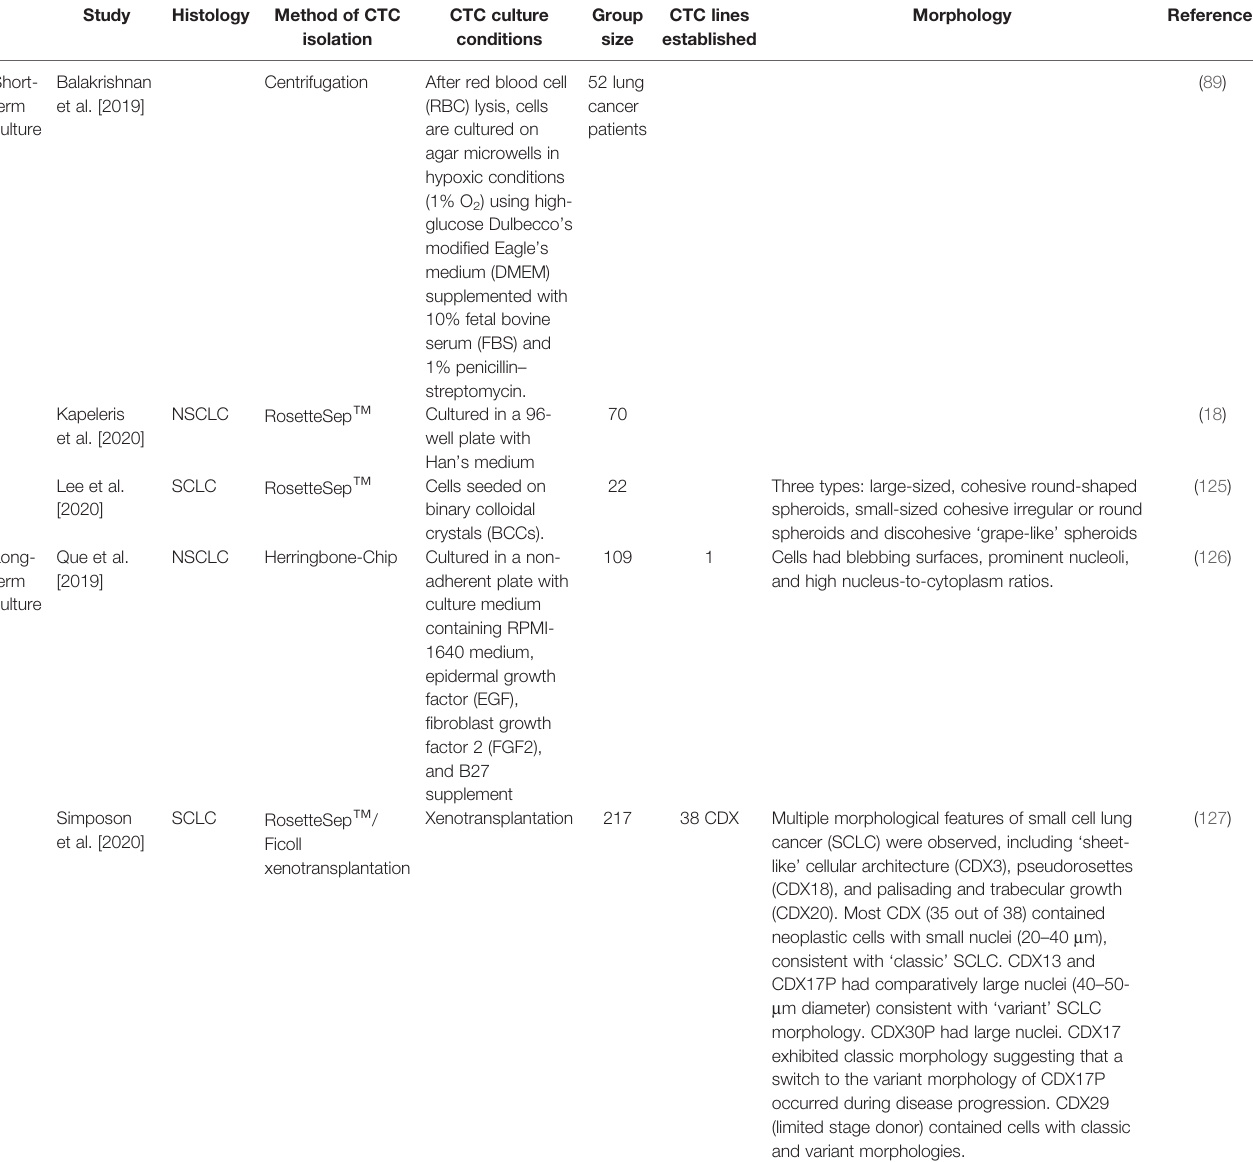
TABLE 3 | Circulating tumour cell cultures derived from blood samples obtained from lung cancer